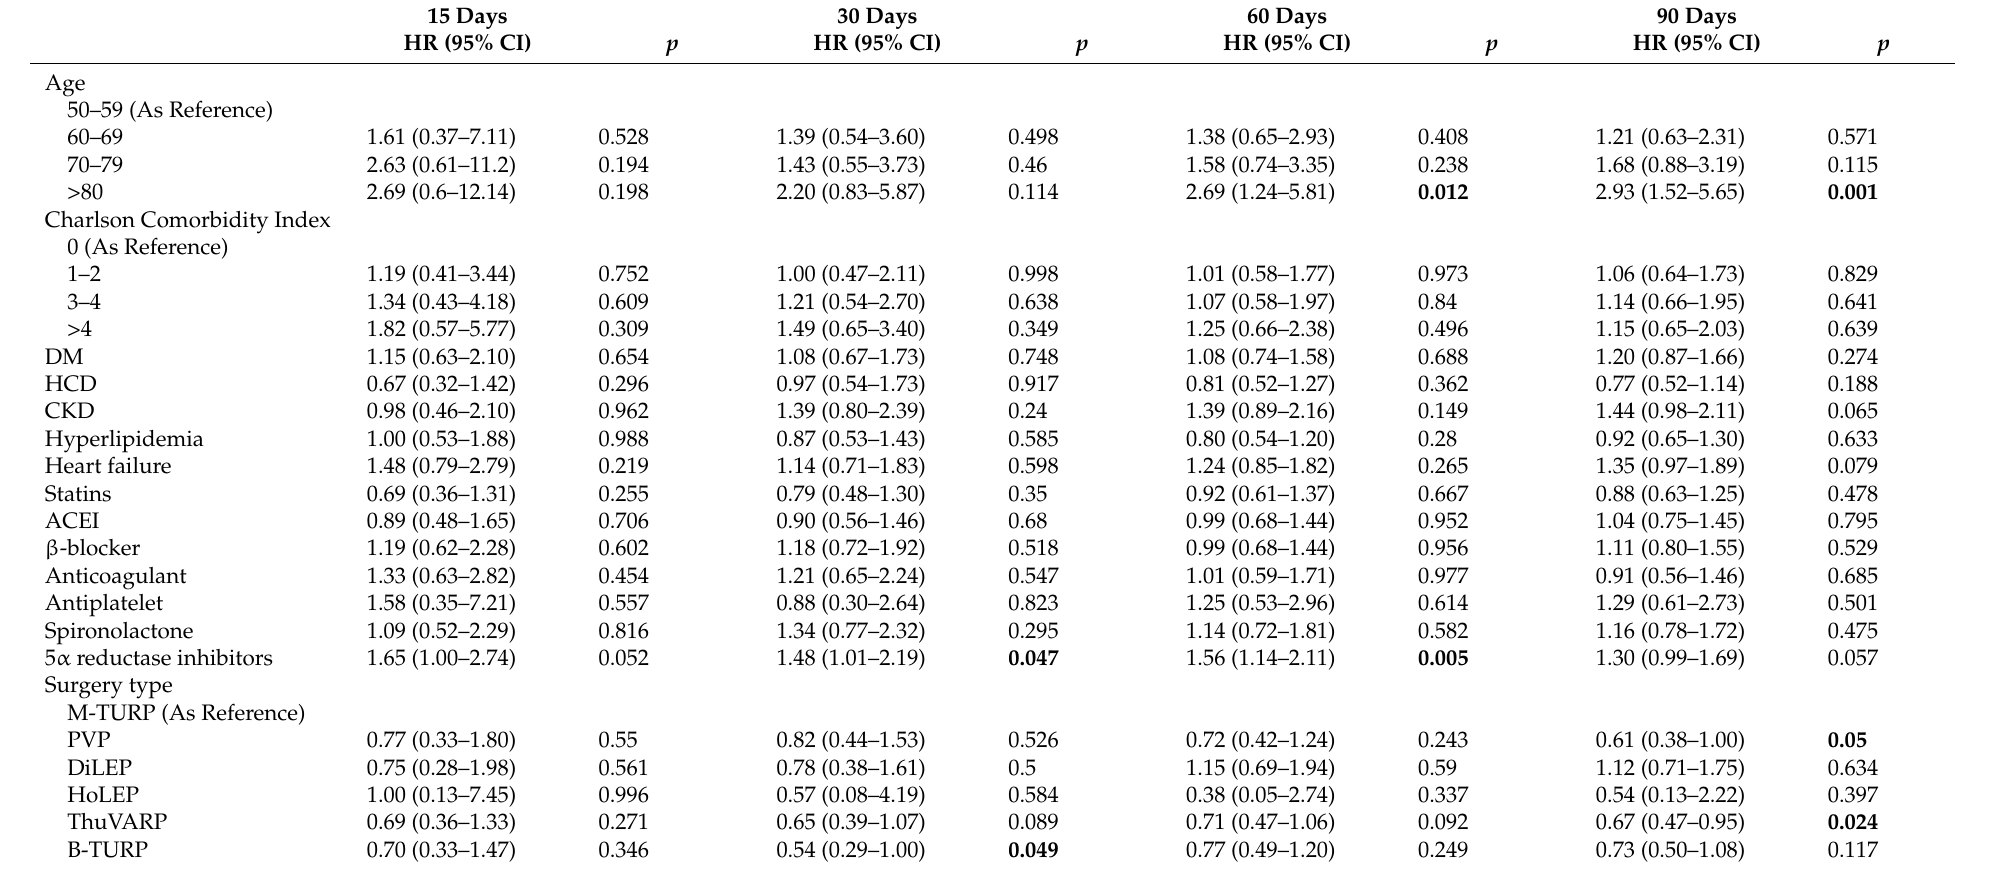
Table 5. Adjusted hazard ratios for rehospitalization due to postoperative bleeding after 15, 30, 60, and 90 days of